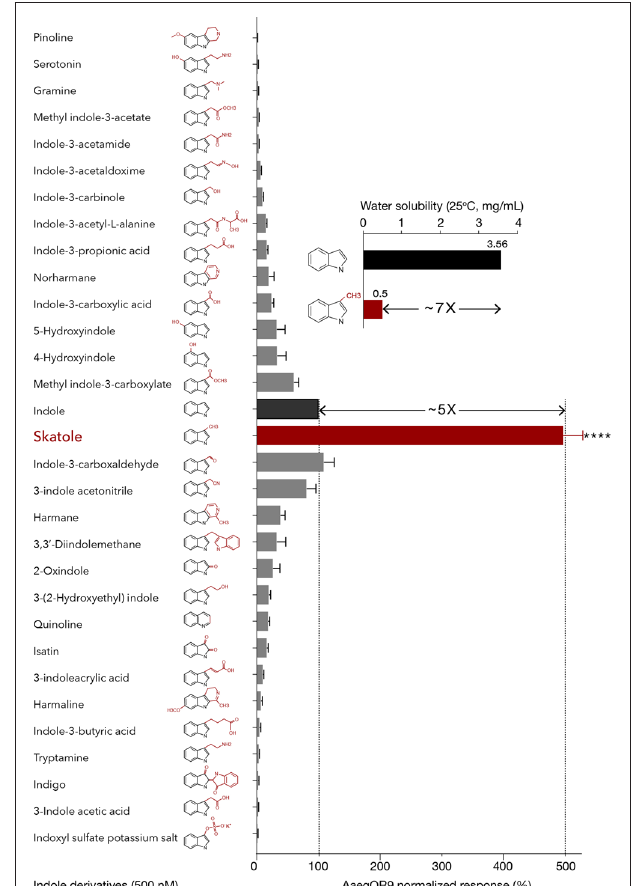
FIGURE 1 | Aedes aegypti OR9 (AaegOR9) is narrowly tuned to skatole. Indole-tuning curve of AaegOR9 to an odor panel comprised of 31 indole derivatives (kurtosis value: 17.75). Skatole is five times more potent than indole ( t -test: ∗∗∗∗ p < 0.0001; n = 10; 100% and 500% response thresholds shown as dotted lines), which is inversely correlated with their respective water solubility (inset). Error bars of average responses indicate standard errors.